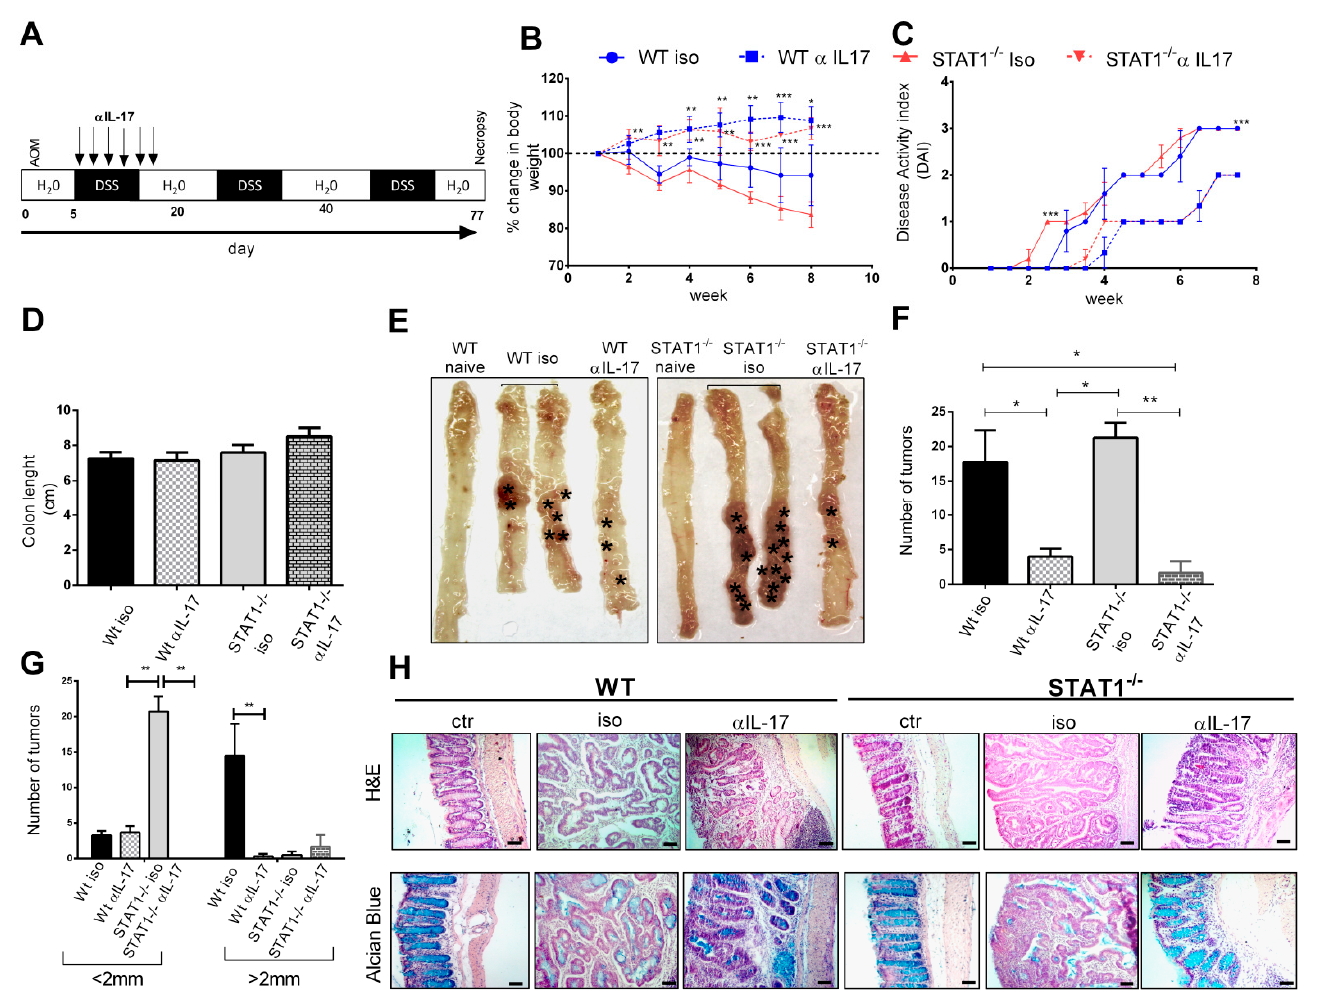
Figure 3. Therapeutic efficacy of IL-17 neutralization in STAT1 -/- mice during CAC: ( A ) WT or STAT1 − / − mice were injected with isotype control or anti-IL-17 neutralizing antibody from day 7 to 19 every other day (black arrows) after AOM/DSS administration. On day 77, the animals were euthanized to analyze tumor development; ( B ) weight changes in WT and STAT1 -/- mice with isotype and anti-IL17-treated mice. The mean weight of mice on day 0 of treatment was taken as 100% and was compared with the weekly weight until the end of the experiment; ( C ) the disease activity index (DAI) score was assessed on the indicated days for each animal and averaged per day for each group; ( D ) colon length, ( E ) macroscopic images of the colon (asterisks are pointing to the tumors), ( F ) number and ( G ) size of tumors 77 days after AOM injection; ( H ) colon sections stained with H&E as well as with Alcian blue to visualize goblet cells. Scale bars: 50 µm. Data shown are the mean ± SEM of at least four or five mice per group and are representative of two individual experiments with similar results per day of the analysis. * p < 0.05, ** p < 0.01, *** p < 0.001.